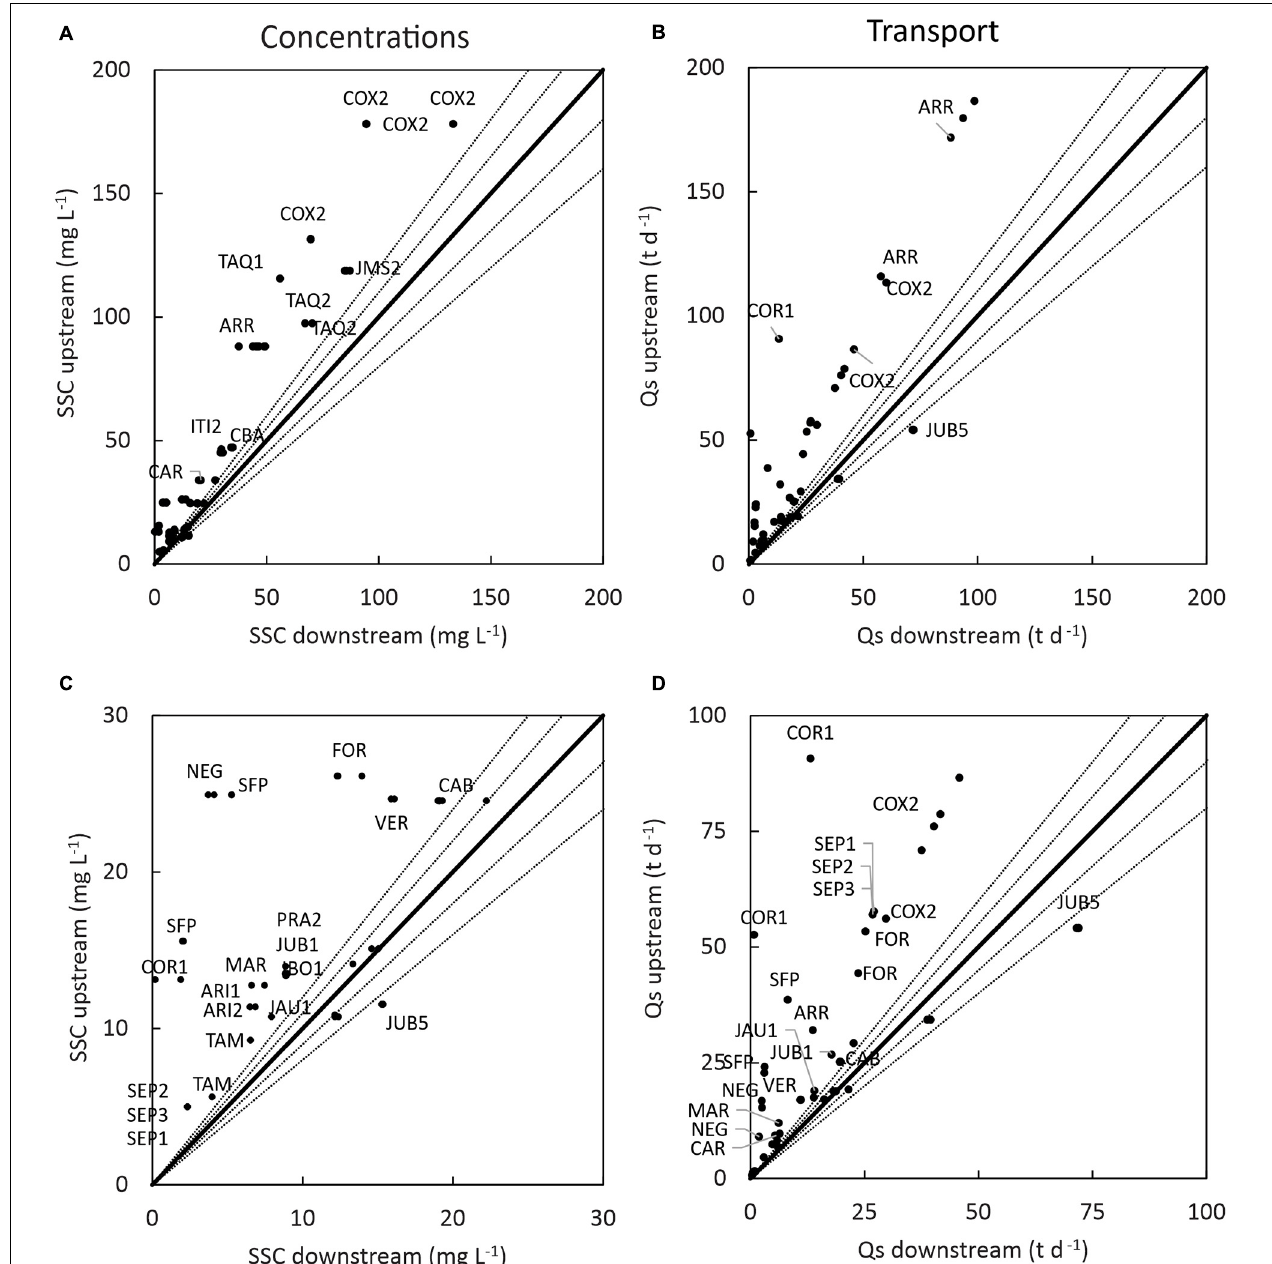
FIGURE 8 | Comparisons of neural network model predictions of changes in suspended sediment concentrations (SSC) and transport (Qs) between upstream and downstream of future hydroelectric facilities, with river systems labeled by codes in Table 1 . (A,B) All data on concentrations and transport, respectively; (C,D) the same data with high values excluded. Solid line shows the line of parity and dashed lines show bounds of ± 10 and ± 20% around that line; points above the line indicate net retention and those below indicate net release between the upstream and downstream sampling points. Upstream:downstream ratios that deviate considerably from 1:1 are identified with the codes shown in Table 1